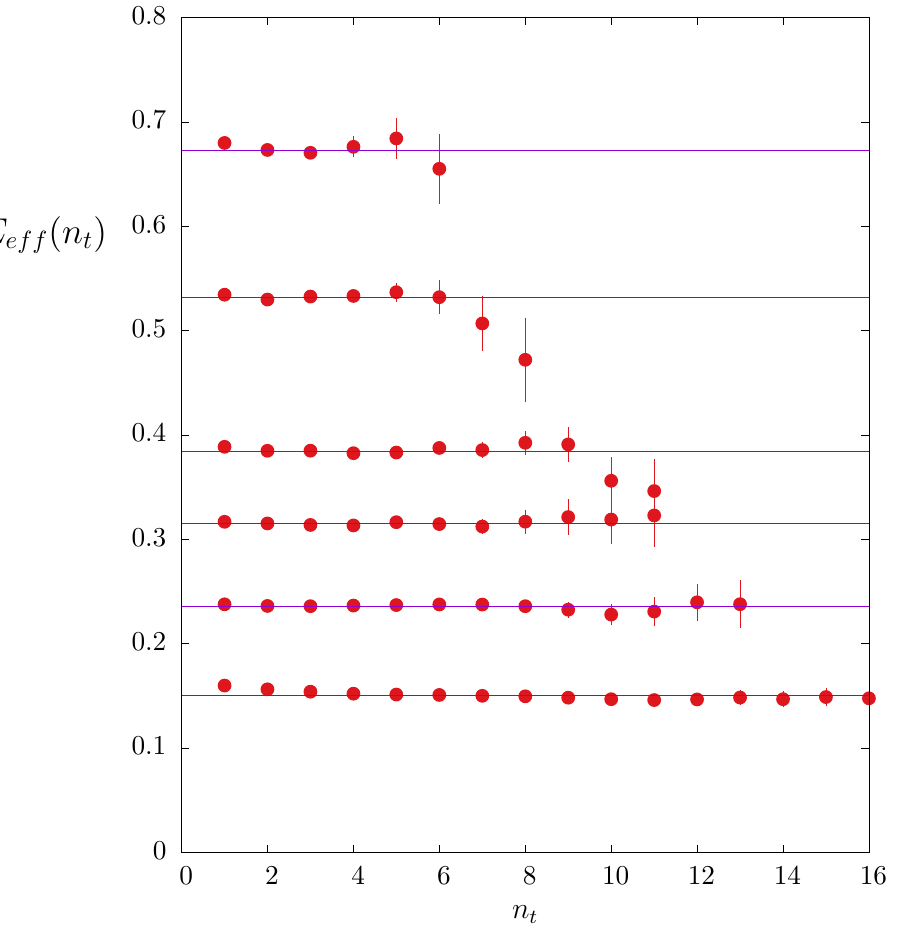
Figure 10 . E(cid:11)ective energy of a (cid:13)ux tube of length l in SO(8) at (cid:12) = 86, as a function of n t = t=a for l = 12 ; 16 ; 20 ; 24 ; 32 ; 40. Lines are our energy